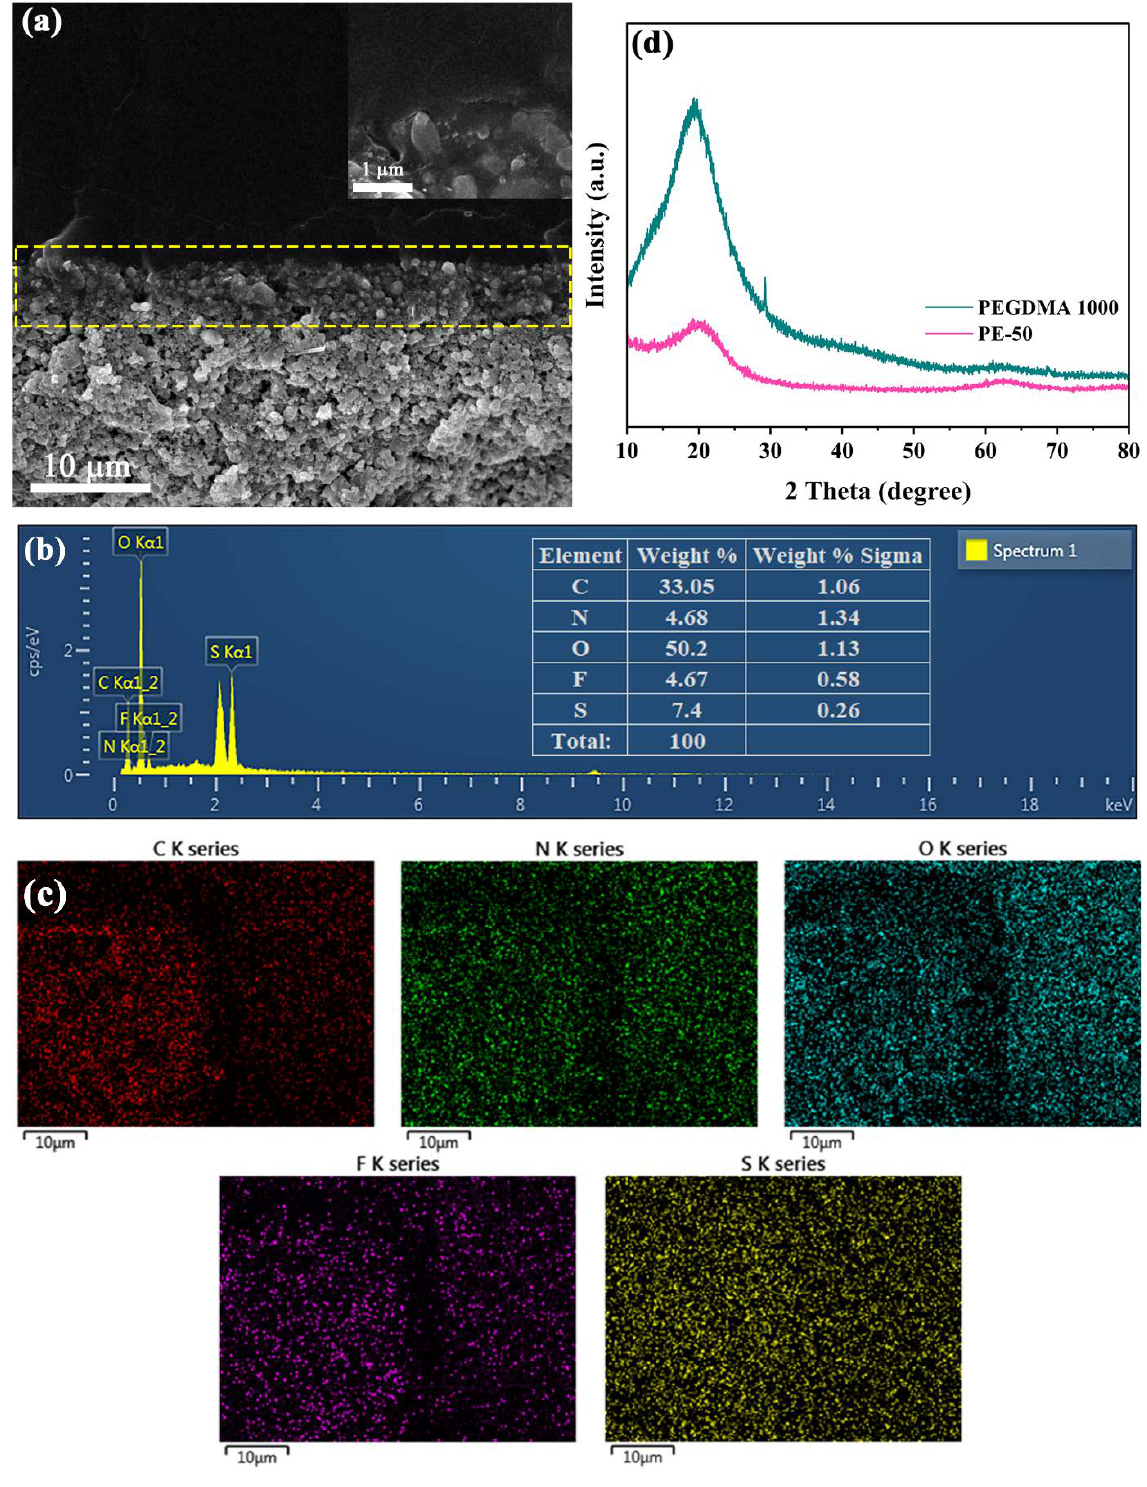
Figure 4. ( a ) Cross-sectional and ( b ) EDS analysis, ( c ) elemental mapping of C, N, O, F and S of PE- 50, ( d ) XRD pattern of precursor solution and PE-50. ( d ) XRD pattern of precursor solution and